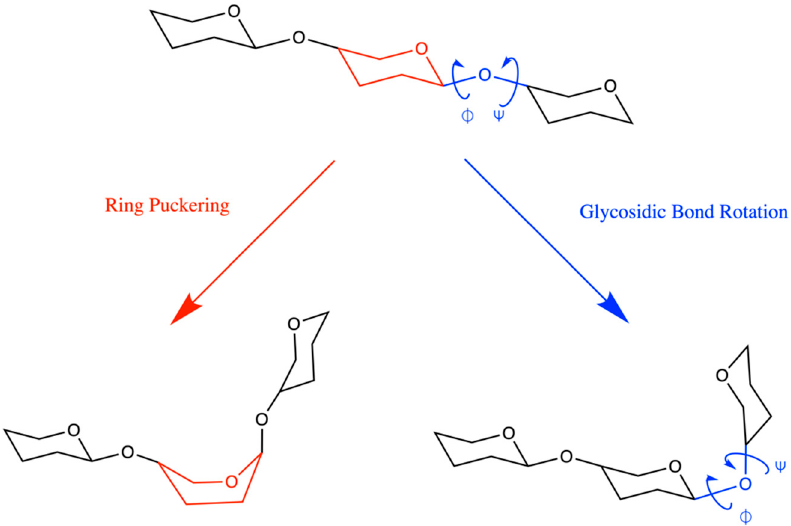
Figure 2. Pyranose ring puckering (red) and glycosidic bond rotation (blue) are the major sources of polymer flexibility in vertebrate glycans.